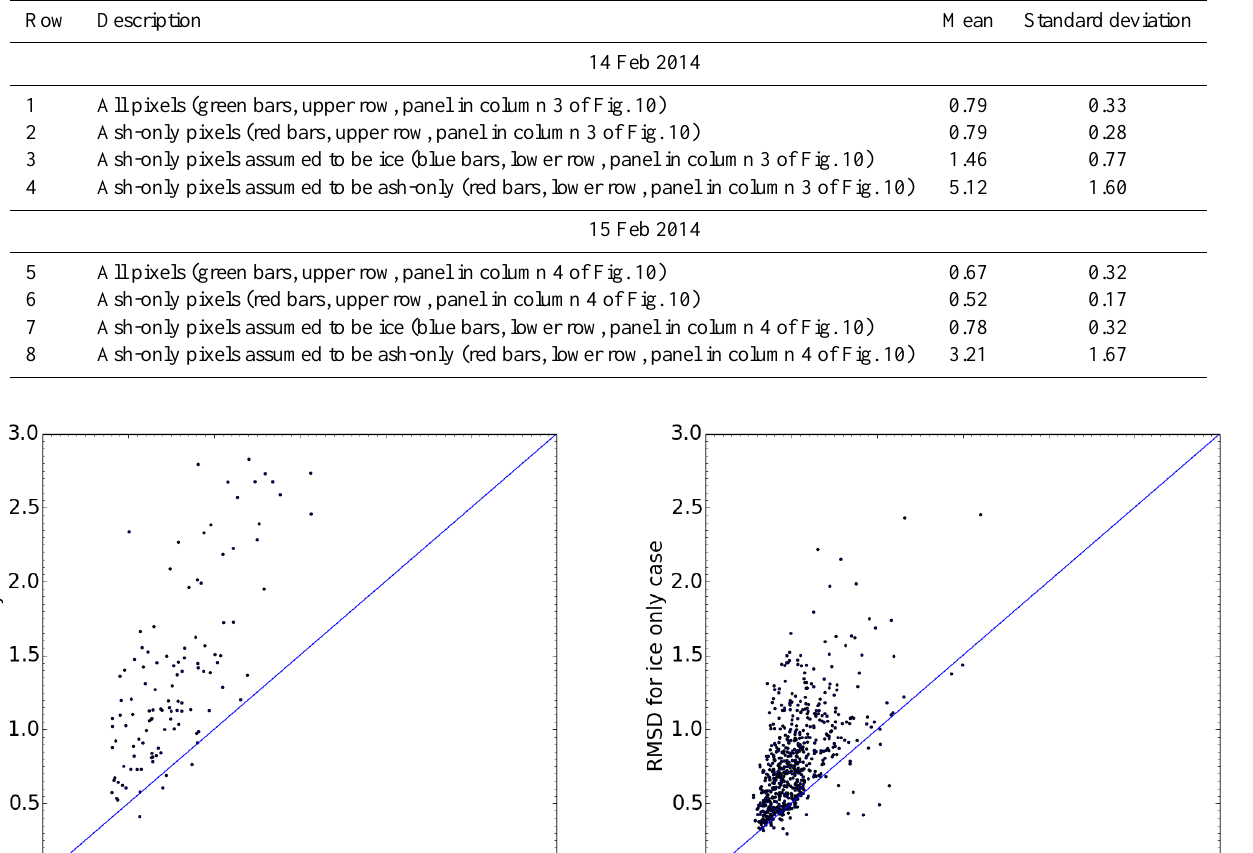
Table 2. The mean and standard deviation of the frequency distributions shown in Fig. 10.